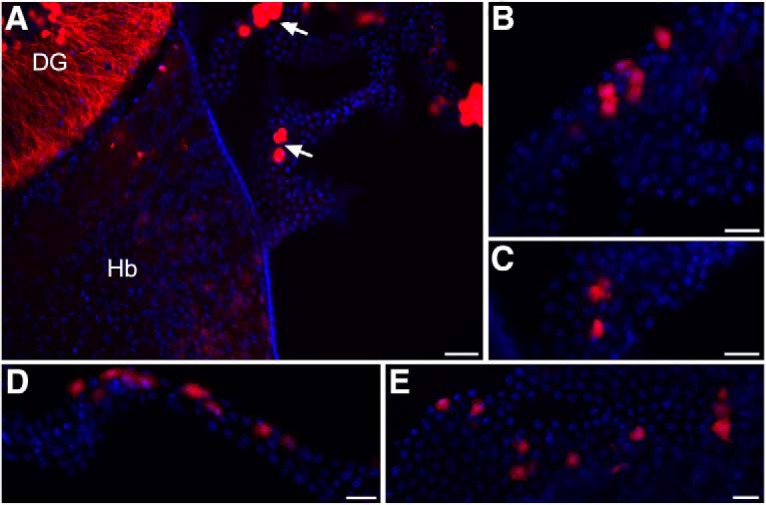
 Cholinergic choroid plexus epithelial cells. A, Visualization of cholinergic cells in transgenic mice expressing td-Tomato fluorescence under the ChAT promotor. Cholinergic cells (red) are found within the dentate gyrus of the hippocampus (DG), habenula (Hb), and the choroid plexus of the d3V (arrows). ChAT: red; DAPI nuclei: blue. Scale bar = 50 μm. B, Higher magnification of the choroid plexus epithelium from the top arrow in panel A illustrates scattered expression pattern with groups of adjacent cholinergic-positive cells. Scale bar = 25 μm. C, Higher magnification image of the epithelium from the bottom arrow in panel A. Scale bar = 25 μm. D, Cholinergic-positive cells were also identified in the lateral ventricle with a similar expression pattern. Scale bar = 25 μm. E, In the fourth ventricle choroid plexus, similar ChAT expression was observed in a subset of epithelial cells. Scale bar = 25 μm.